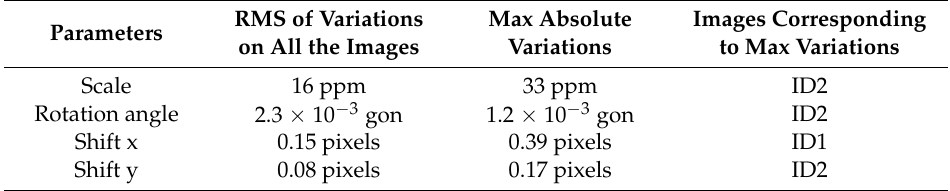
Table 6. Comparison between results obtained with the ‘slave-to-master’ and the MIRA approach for image registration on ‘Multan’ dataset (ppm: part-per-million). In both cases automatically-extracted TPs have been